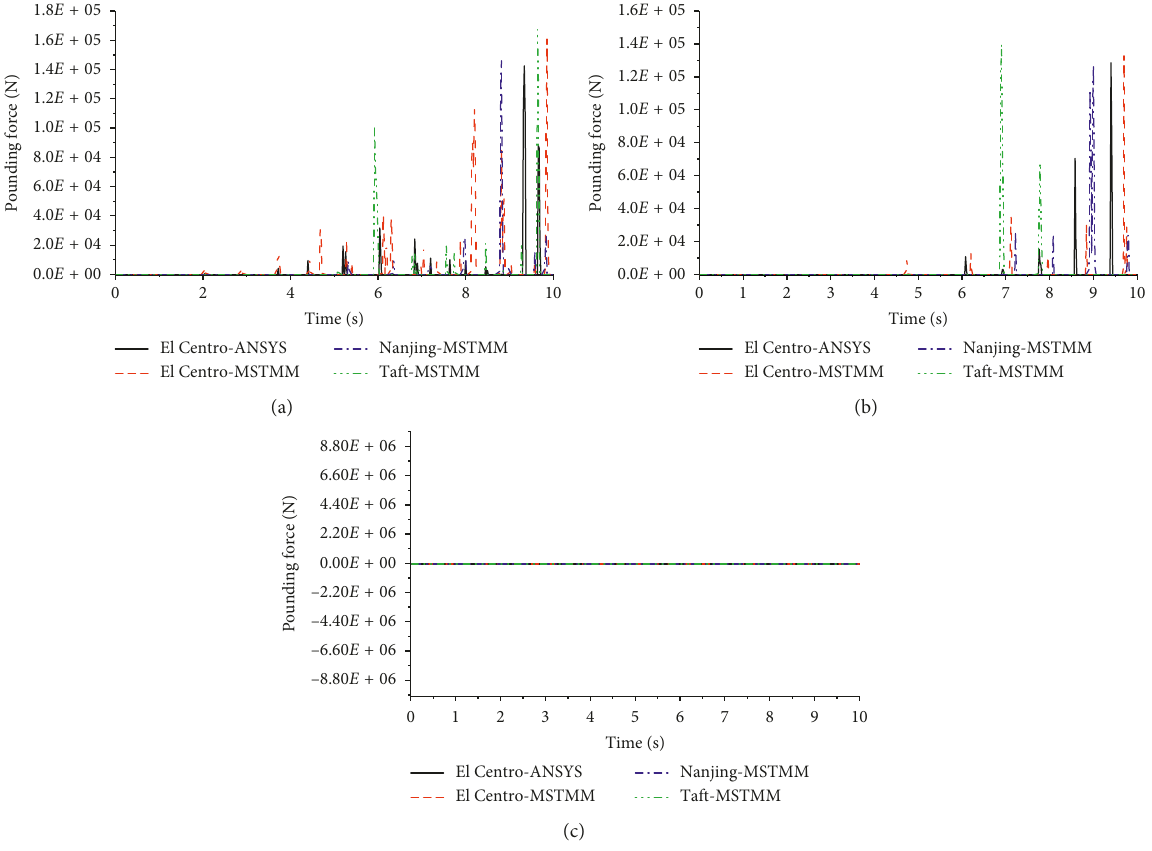
Figure 11: Time-history diagram of J and (c)